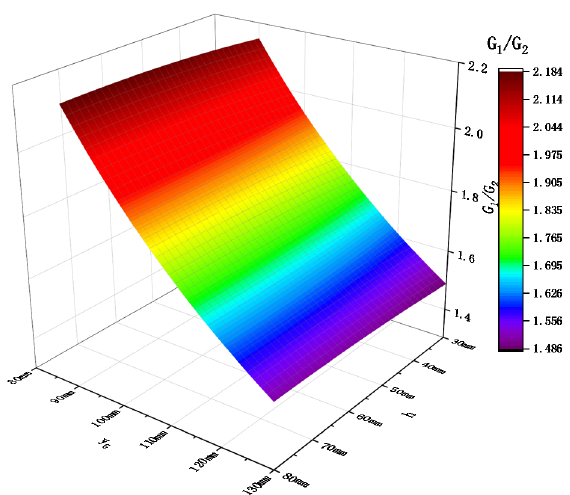
Figure 8. Relationship between minimum mass distribution requirements and frame centroid y G and installation height h of flip motor.